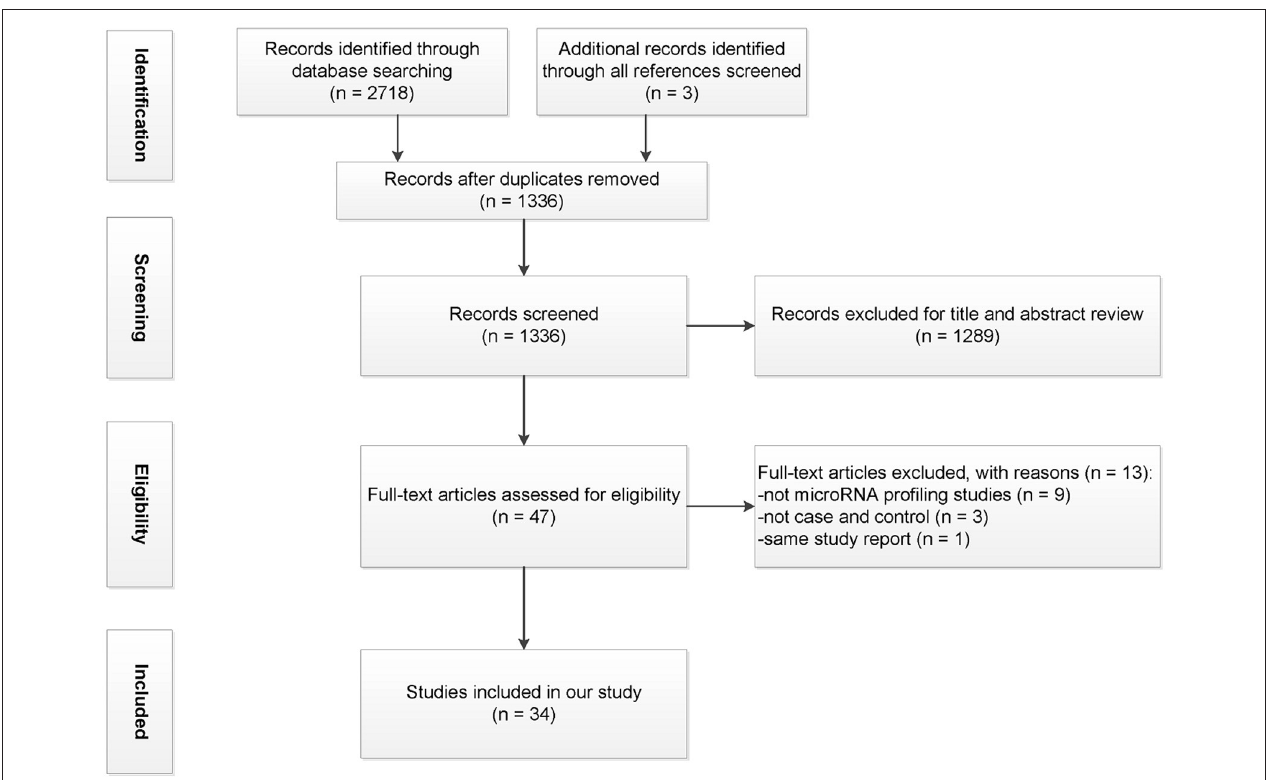
FIGURE 1 | Flowchart illustrating the process of study selection.